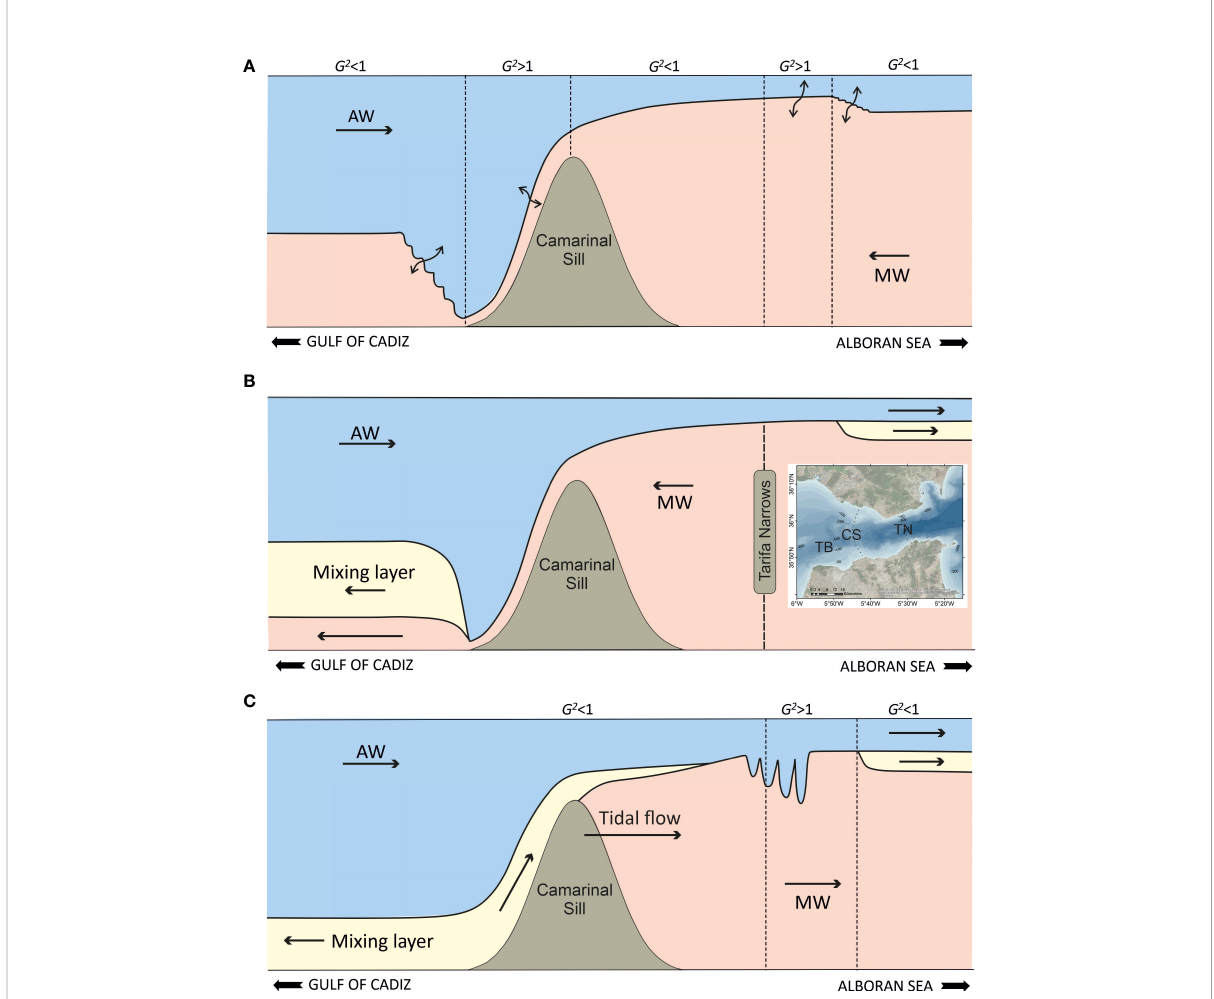
FIGURE 5 Sketches of the fl ow through the SoG. (A) The steady two-layer maximal exchange with internal hydraulic control at the Camarinal Sill and at the Tarifa Narrows. Double arrows indicate regions of enhanced mixing. The wiggling interface represents internal hydraulic jumps. (B) Three- layer representation of the steady fl ow through the SoG. Vigorous mixing has created an intermediate mixing layer that widens towards both ends of the strait (particularly west of the Camarinal Sill where mixing is strongest). The inset shows the location of the Camarinal Sill (CS) and the Tarifa Narrows (TN) within the Strait. (C) Snapshot of the tidally-forced three-layer exchange. Tidal fl ow points towards the AS; hydraulic control has been lost over the sill and the hydraulic jump can now propagate eastward, breaking up into a series of solitary waves. The Mediterranean layer over the sill has been reverted by the tidal fl ow, allowing for the intrusion of mixing water from the Tangier Basin (TB in the inset; west Camarinal Sill) into the